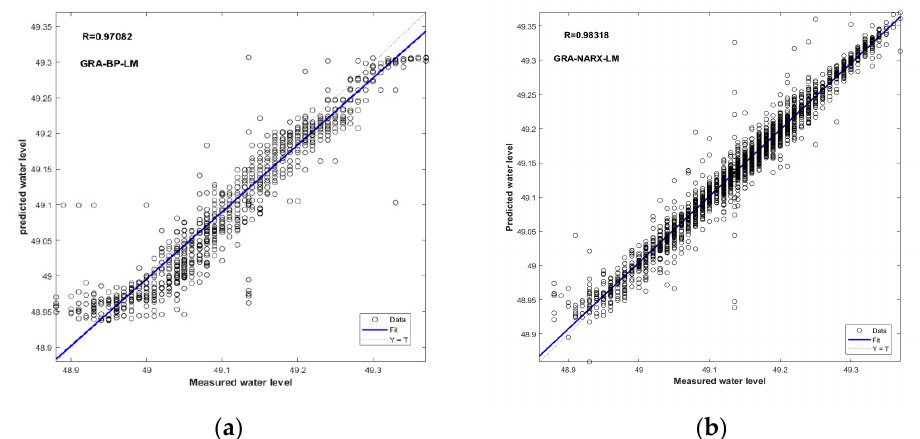
Figure 10. Scatter plots of measured and predicted water levels for the GRA-NARX and GRA-BP models using LM as the training algorithm: ( a ) GRA-BP-LM, ( b ) GRA-NARX-LM.